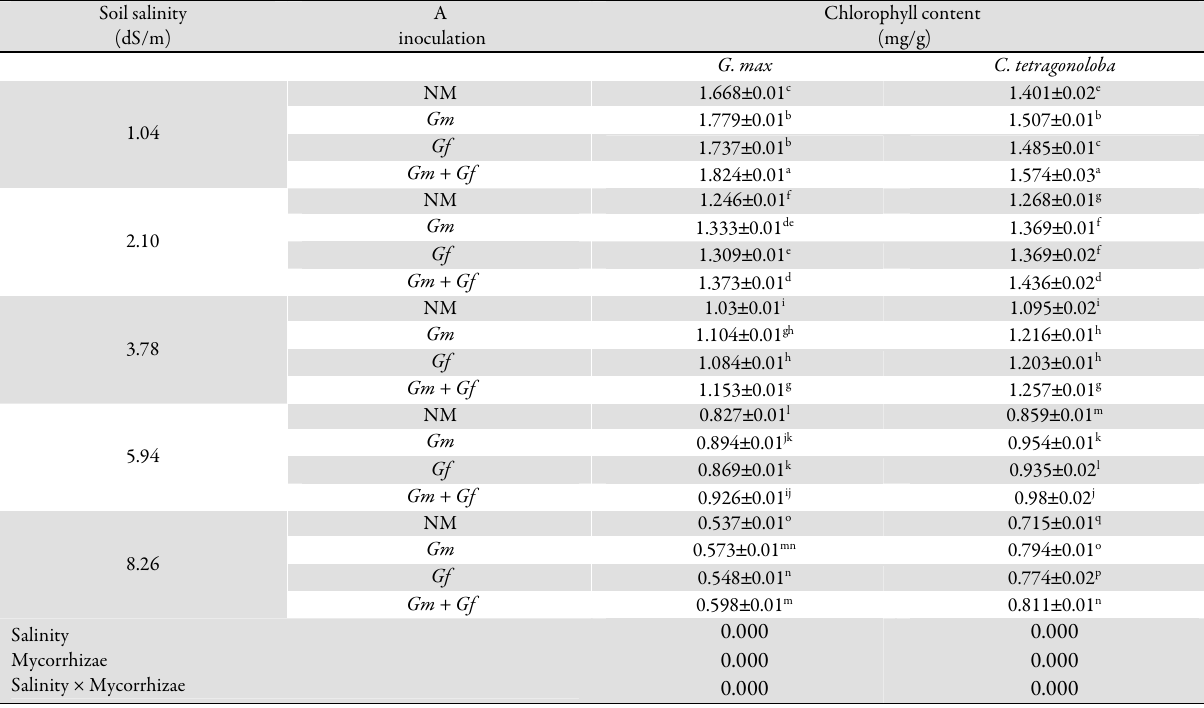
Tab. 2. Total chlorophyll content (mg/g) of mycorrhizal and non-mycorrhizal G. max and C. tetragonoloba grown under control (1.04dS/m) and at increasing soil salinity levels (2.10 to 8.26